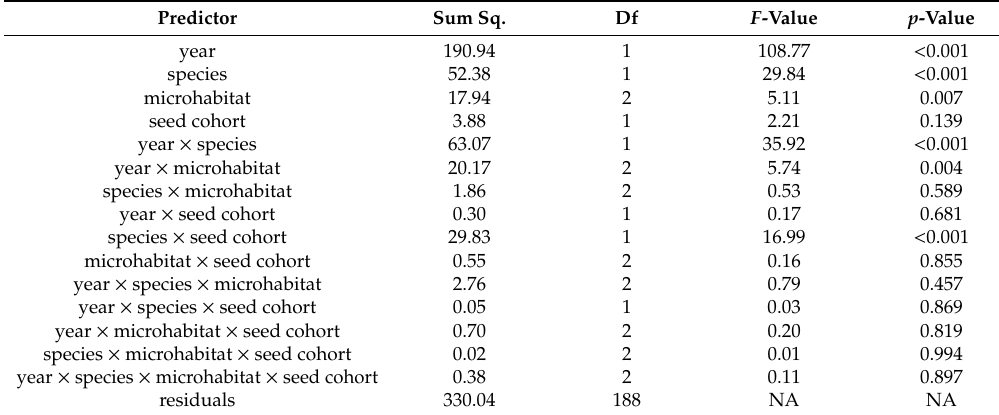
Table 2. Results from quasibinomial generalized linear model evaluating e ff ects of year, species, microhabitat, seed cohort, and all interactions on the retained seed pool. Bold text indicates a significant di ff erence at the p ≤ 0.05 level 1 ; italic text indicates a marginally significant di ff erence at the p ≤ 0.10